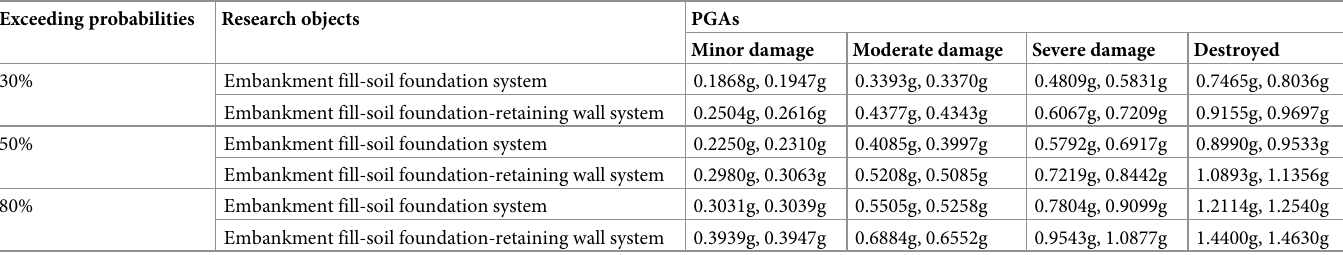
Table 6. PGAs corresponding to each seismic damage grade with different exceeding probabilities.